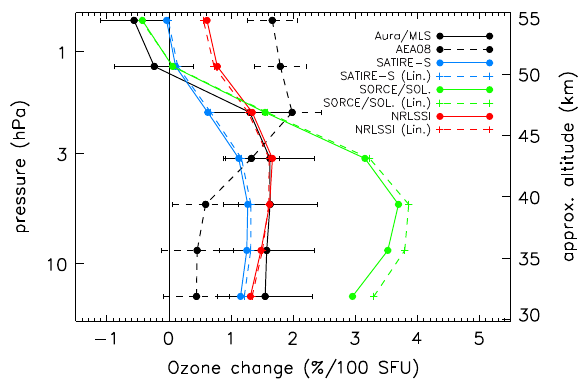
Fig. 1. The solar cycle signal in the ozone profile, D O 3 ( z ), in the equatorial stratosphere: (i) derived from observations, (dashed black curves) Austin et al. (2008) and (solid black) AURA/MLS; (ii) derived using various solar spectra as input to the HP model: (solid blue) SATIRE-S, (red) NRLSSI and (green) SORCE/SOLSTICE (using SATIRE-Sabove 290 nm) and (iii)constructed fromthe (dashed)linear approximation with the SC flux changes given in